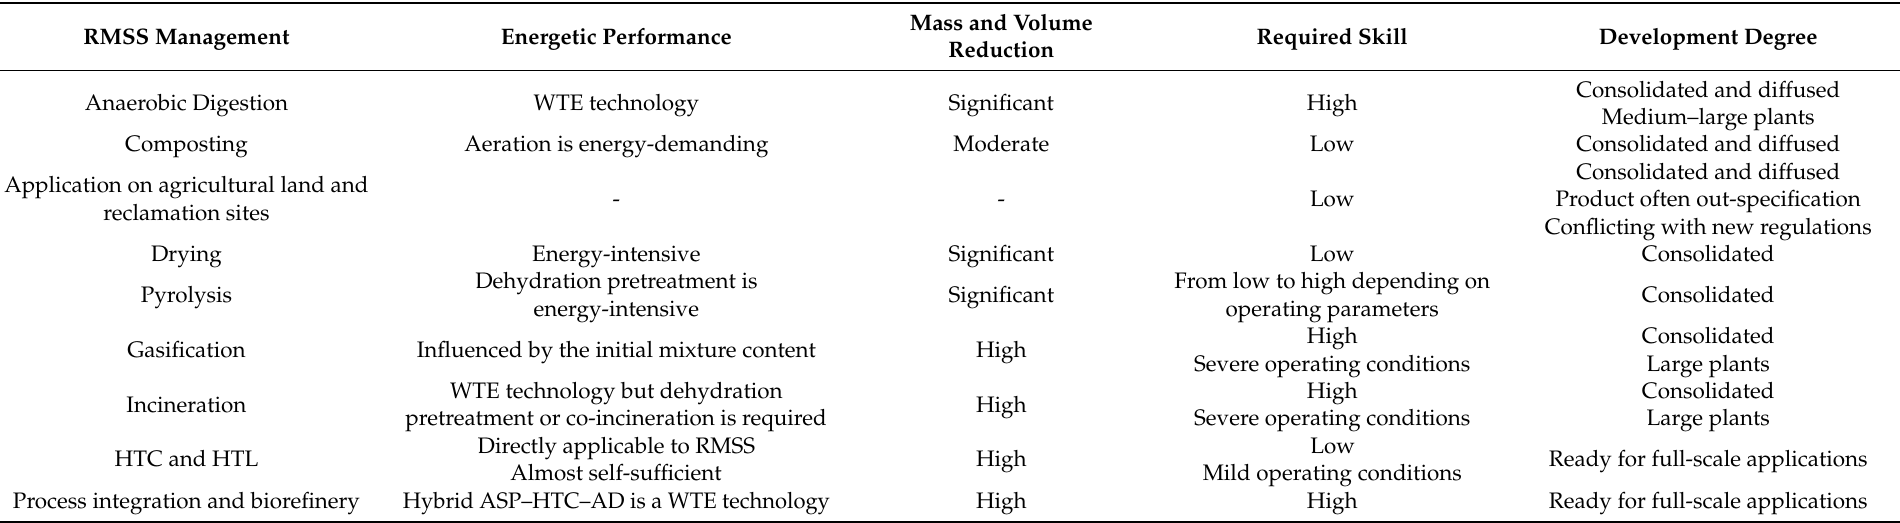
Table 6. Comparison between the main applicable technologies on RMSS